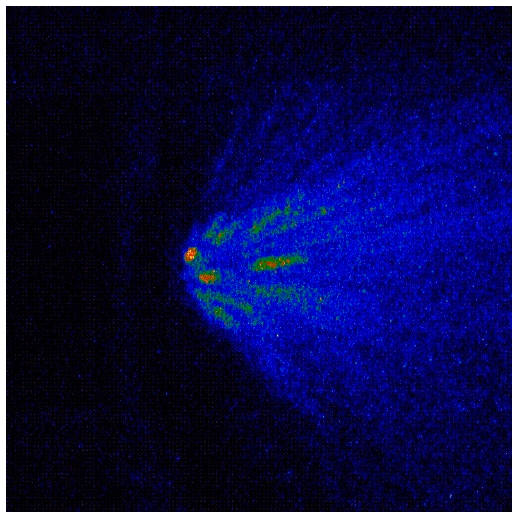
Figure 12. ICCD image of the third emission of material. The image was recorded at 30 μ s after the laser shot with a gate of 20 μ